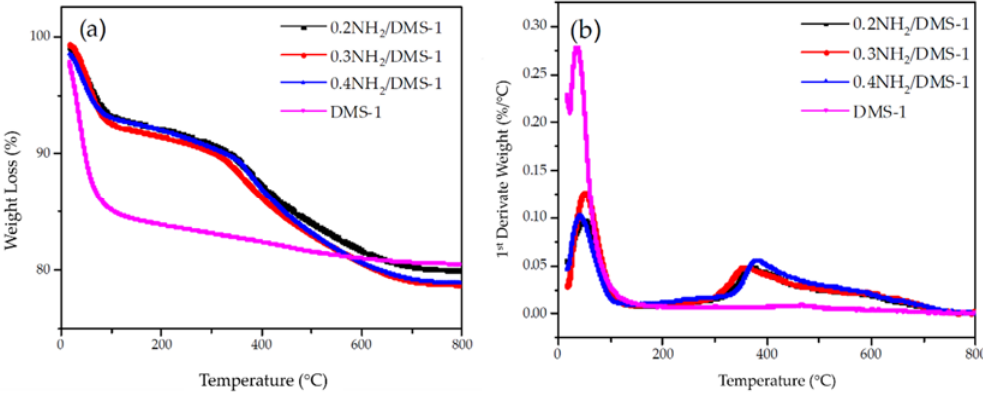
Figure 5. Weight loss analysis: ( a ) Thermogravimetric Analysis, and ( b ) Derivative Thermogravimetry for the bare DMS-1 and the amino-functionalized